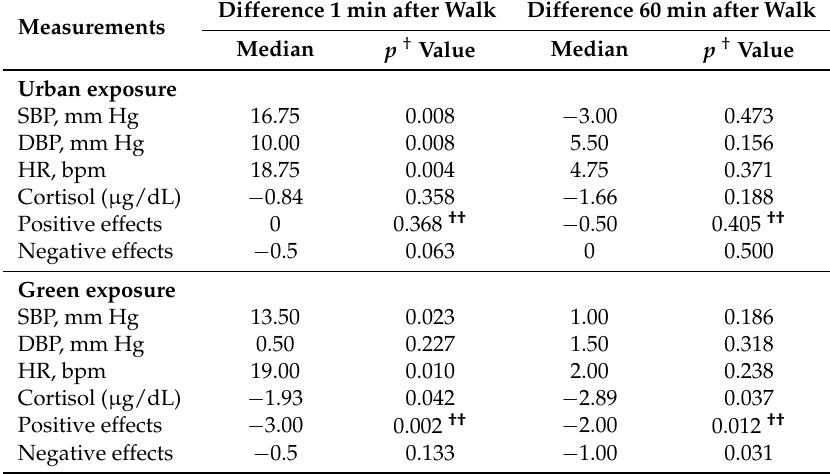
Table 3. The difference of hemodynamic parameters, cortisol, and mood after the first day walk in urban and park environments.